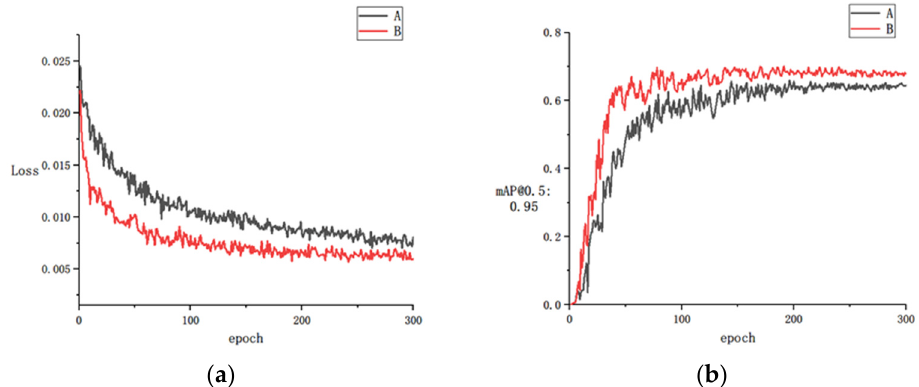
Figure 10. Comparison of AB model training parameters before and after improvement.